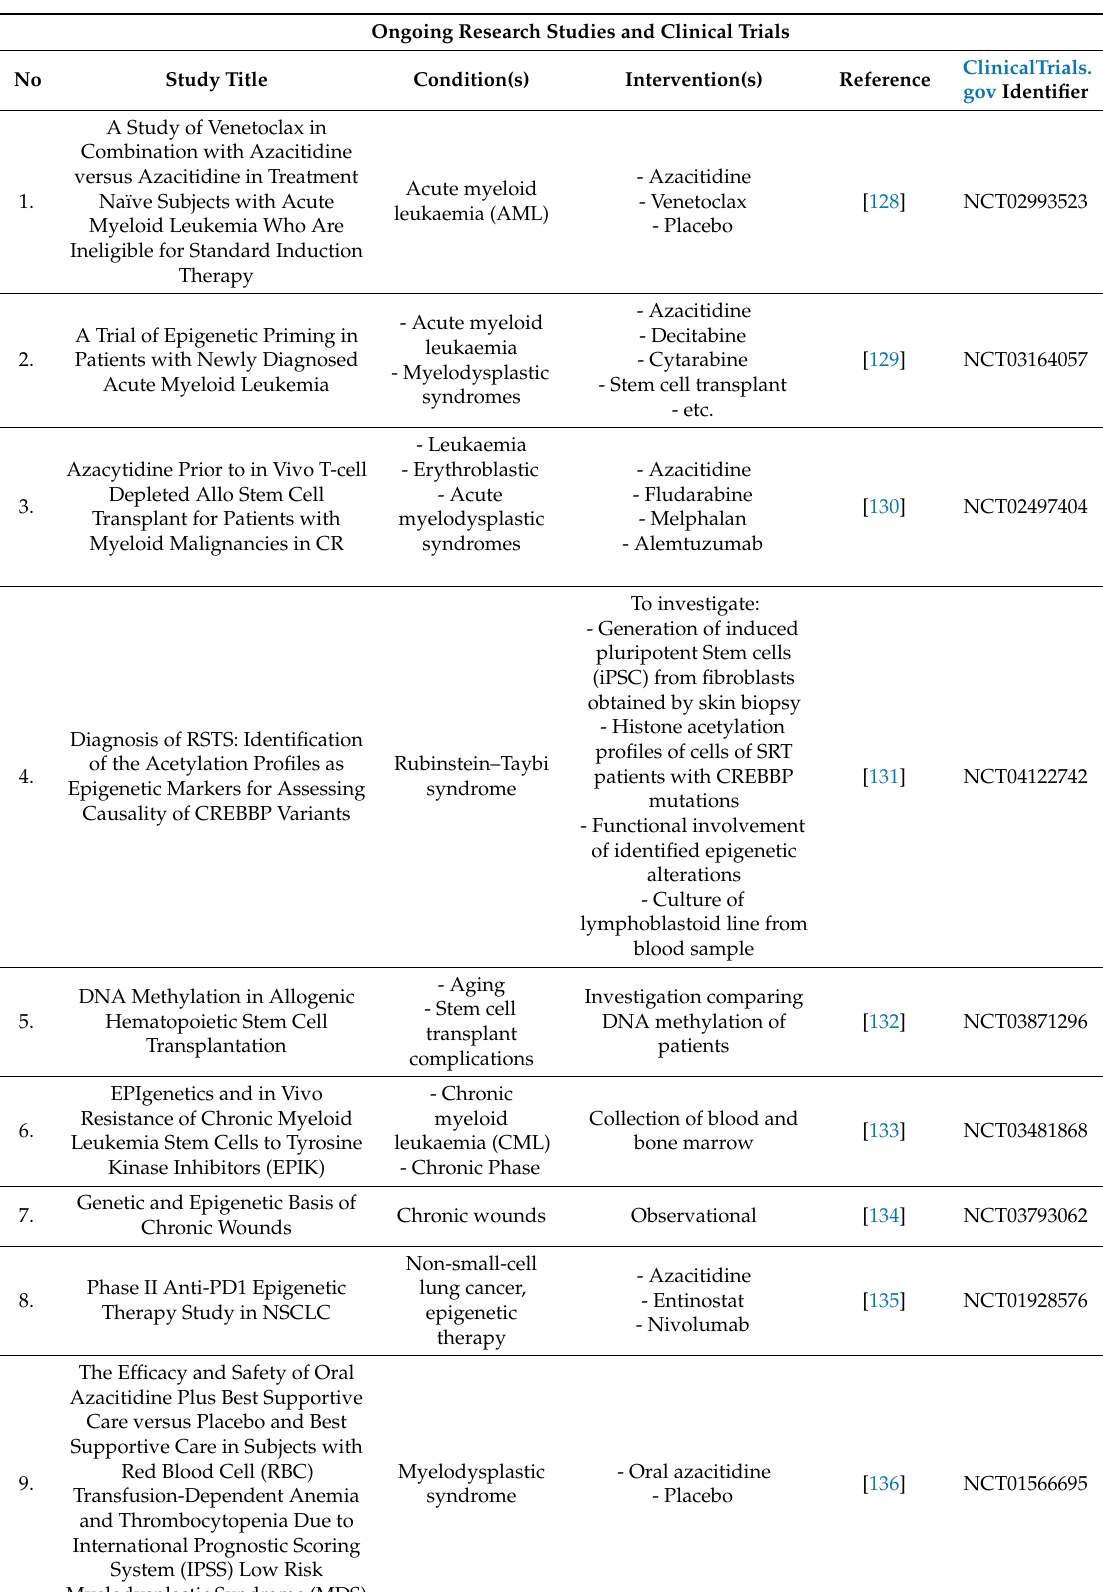
Table 2. A list of ongoing research studies and clinical trials relating to the topic, arranged in alphabetical